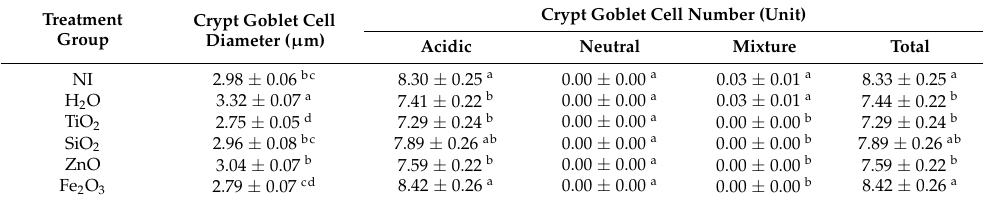
Table 7. Effects of intraamniotic administration of experimental food-grade NP solutions on crypt goblet cell diameter, goblet cell count, and goblet cell type 1 .